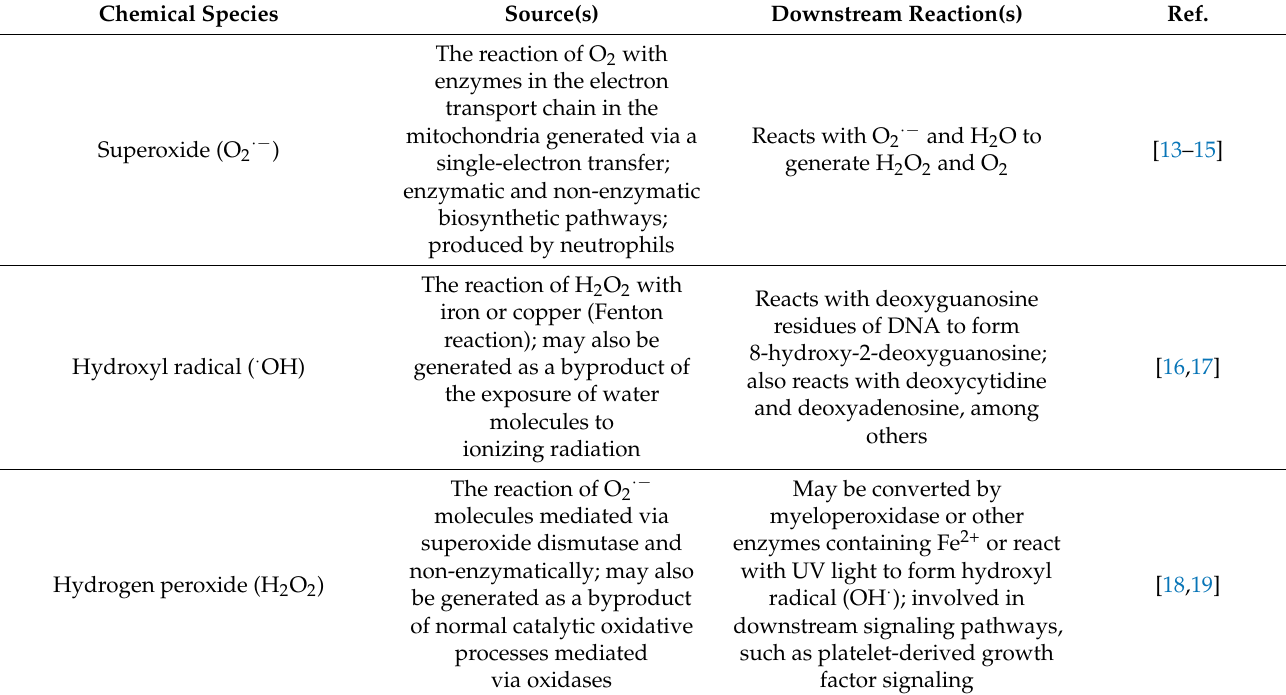
Table 1. Summary of the major chemical species associated with oxidative stress in the eye. Chemical Species Source(s) Downstream Reaction(s)